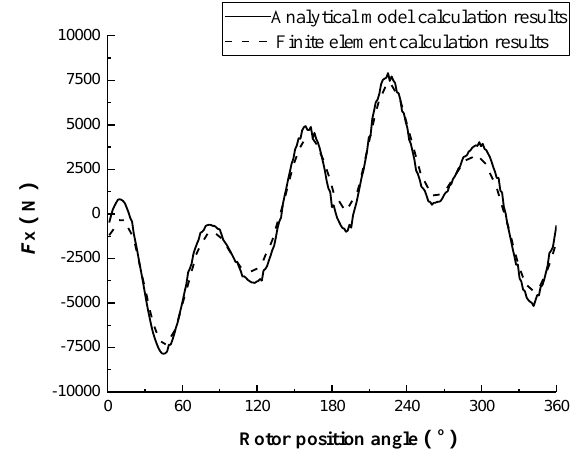
Figure 11. The X -axis unbalanced magnetic pull (UMP) of rotor in fault.